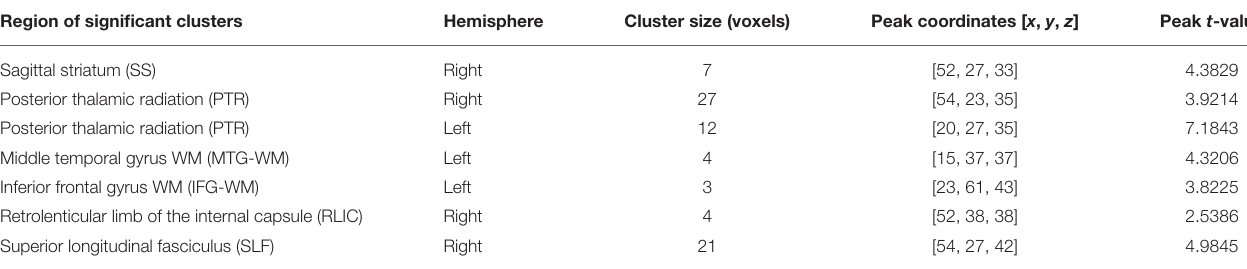
TABLE 1 | Regions with significant FA differences between chronic ketamine exposure group and controls. Region of significant clusters